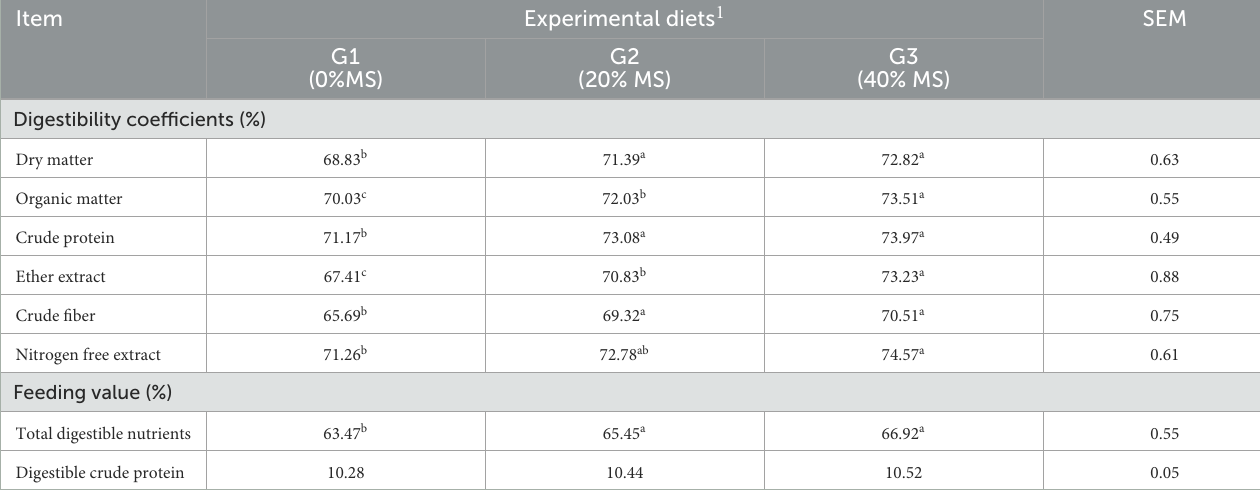
TABLE 4 Digestibility coefficients and feeding values of the tested diets by male kids in the experimental groups.